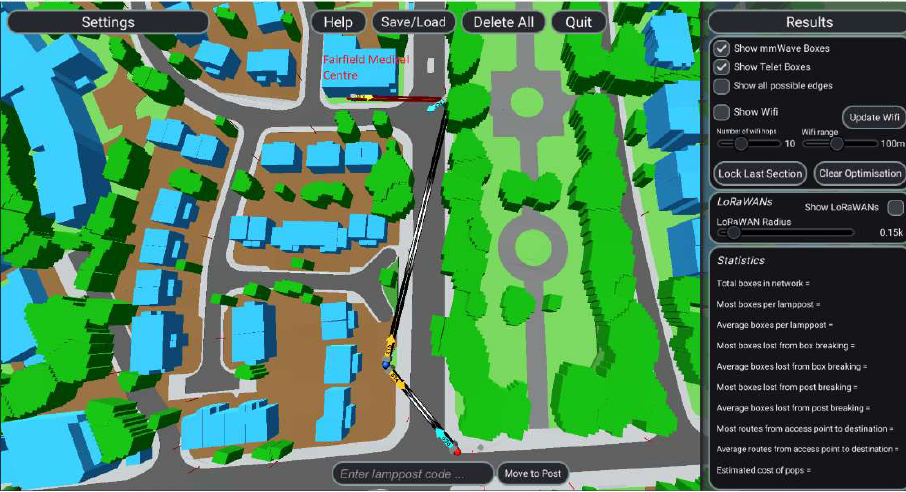
Figure 3. Copy of the Fairfield Medical Centre deployment.